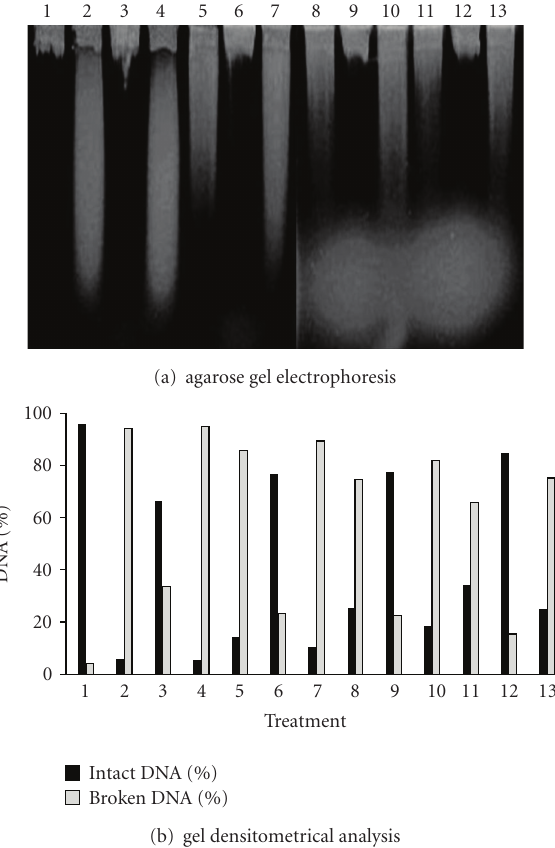
Figure 6: Alkaline gel electrophoresis of E. coli BH20 treated with SnCl 2 (25 μ g/mL), UVA (90kJ/m 2 ) and pre-illuminated with UVA, followed by SnCl 2 incubation. Lanes: (1) control; (2) SnCl 2 ; (3) UVA; (4) UVA + SnCl 2 ; (5) SnCl 2 30 minutes; (6) UVA 30 minutes; (7) UVA + SnCl 2 30 minutes; (8) SnCl 2 60 minutes; (9) UVA 60 minutes; (10) UVA + SnCl 2 60 minutes; (11) SnCl 2 90 minutes; (12) UVA 90 minutes; (13) UVA + SnCl 2 90